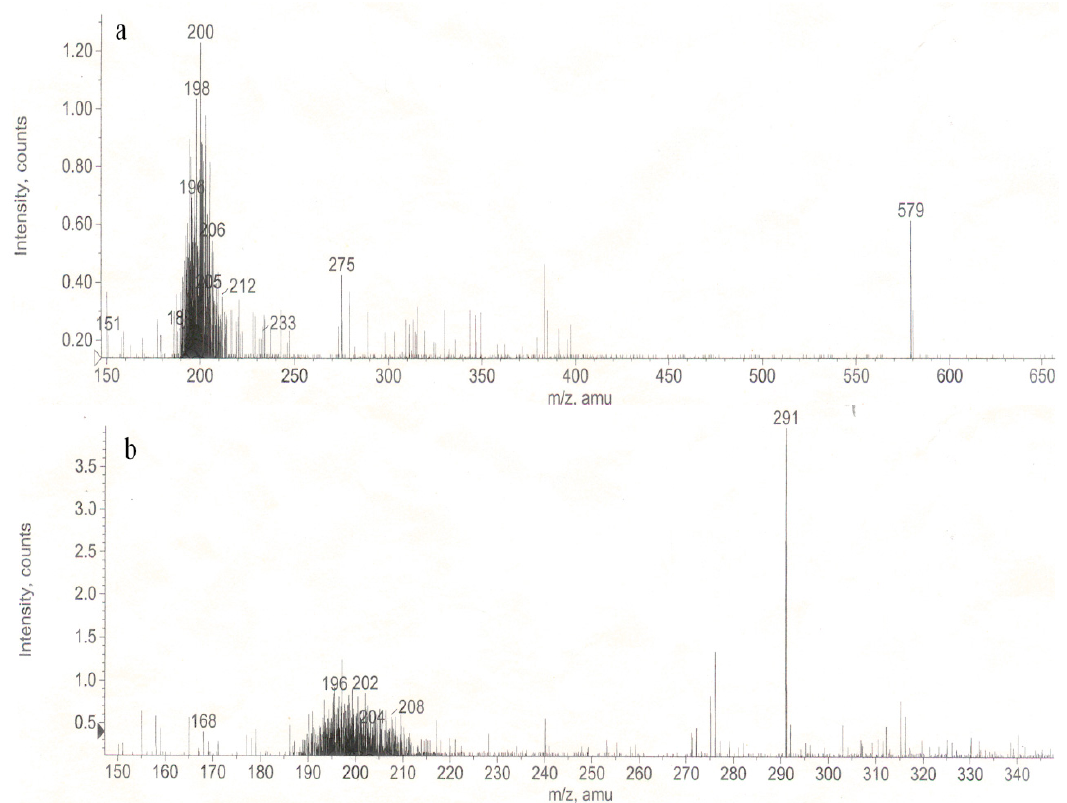
Figure 2. CID MS–MS spectra of ( a ) mass spectrum of syringic acid and ( b ) mass spectrum of epicatechin.